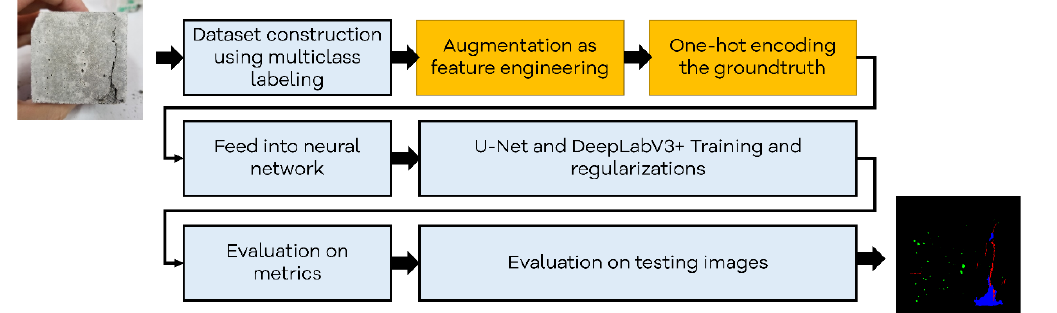
Figure 1. Proposed methodology.